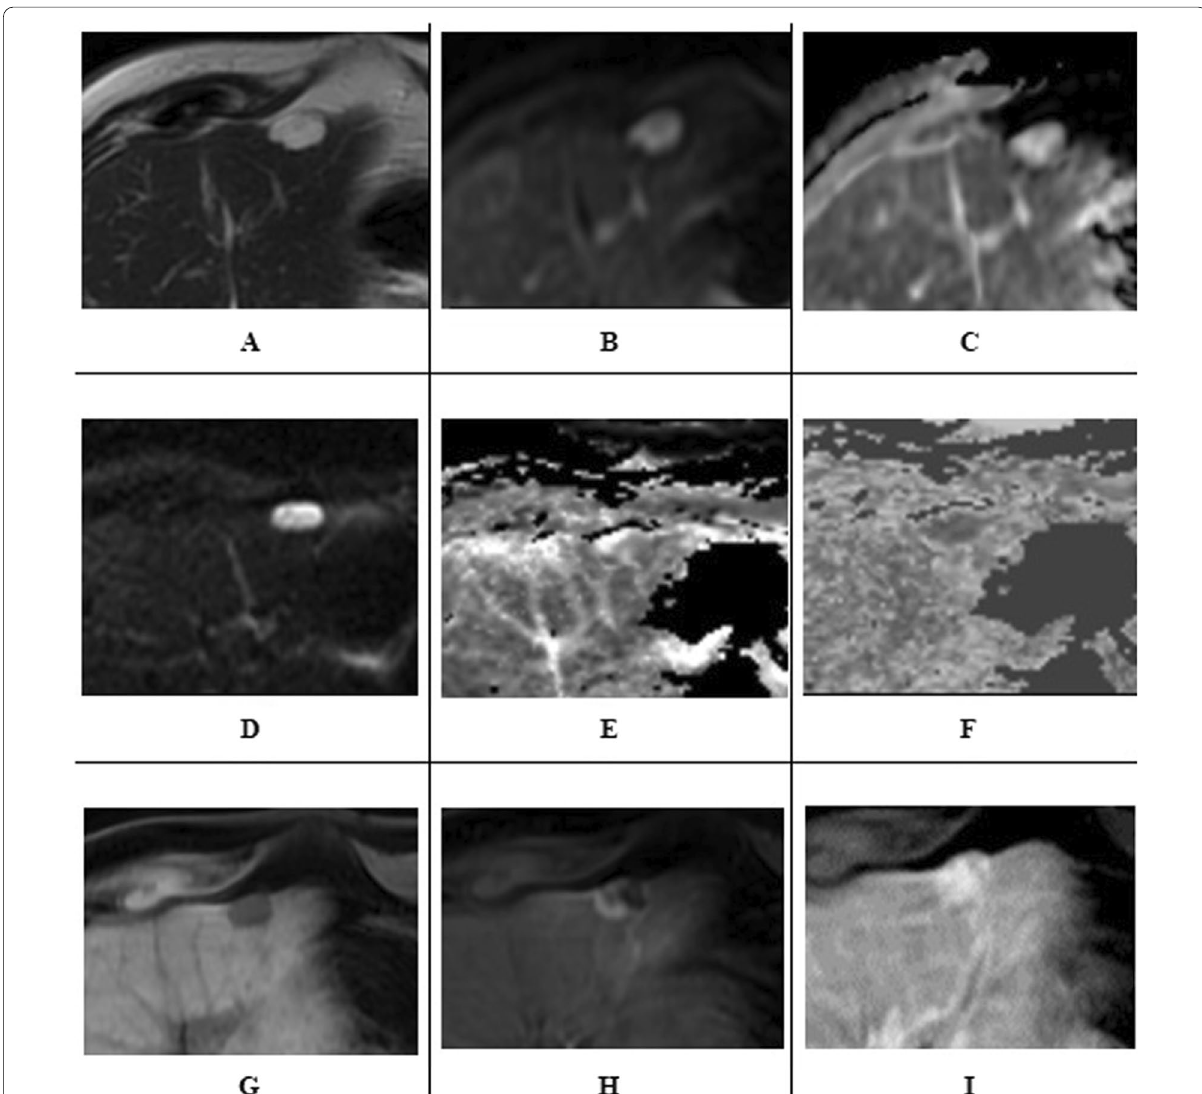
Fig. 4 A 40-year-old HBV positive male patient underwent routine abdominal ultrasonography that showed small left hepatic focal lesion. A A small left lobar segment II focal lesion is seen measuring about 2.3 cm eliciting high T2 signal. B axial diffusion and C ADC images show facilitated diffusion with DWI-ADC value 2.22 10 − 3 D Axial DTI gray scale image, E DTI-ADC map and F FA map: the DTI-ADC value was 2.21 and the FA × value was low 0.26 suggestive of benign nature. G non-contrast T1 H arterial phase and I delayed phase of the dynamic study showed nodular = enhancement that progress into complete filling in the delayed phase, and imaging features were compatible with hemangioma. The lesion